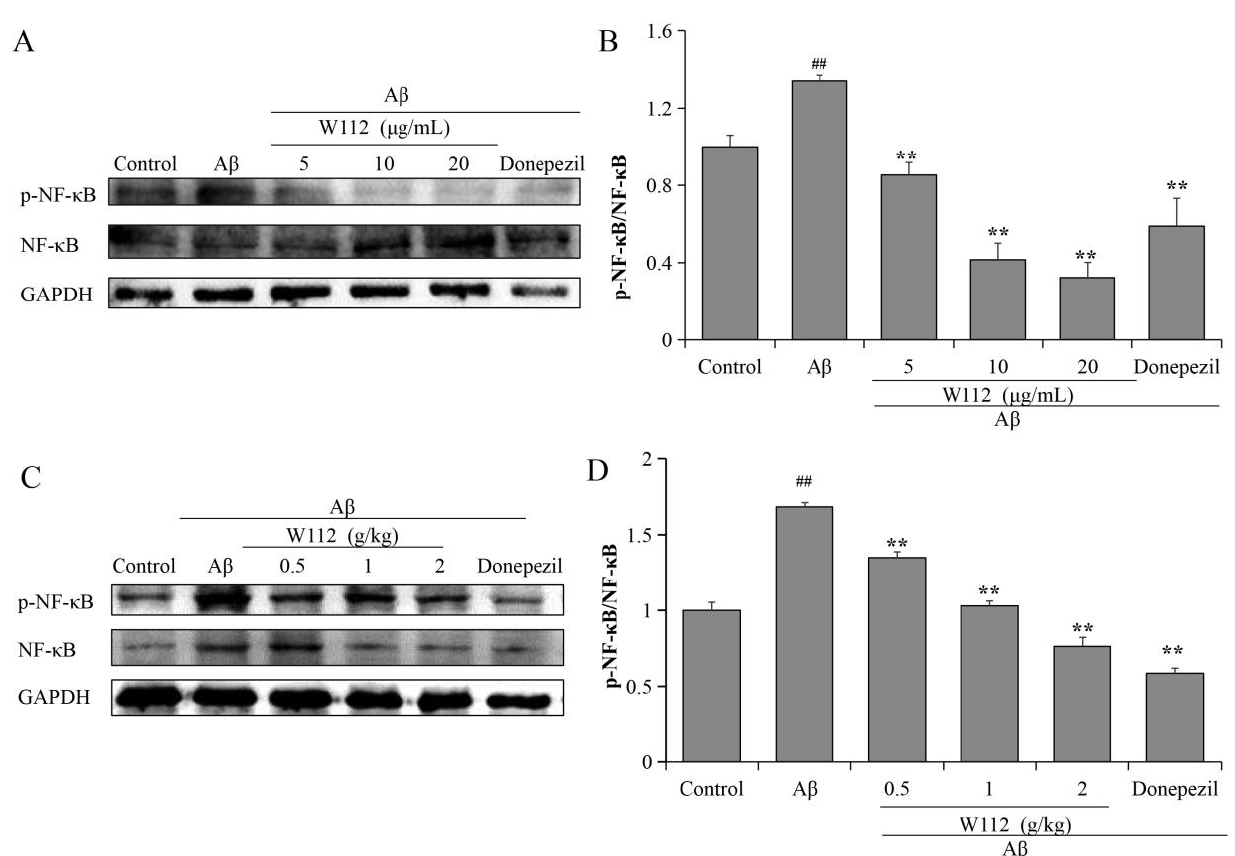
Figure 6. W112 treatment suppressed the phosphorylation of NF- κB signaling pathway in Aβ 25 – 35 - induced cell and rat models. ( A , B ) The phosphorylation and total levels of NF- κB in PC12 cells were measured by Western blot. n = 3. ( C , D ) The phosphorylation and total levels of NF- κB in the hippocampus were measured by Western blot. n = 8. ## p < 0.01 vs. the control group; ** p < 0.01 vs. the model group.